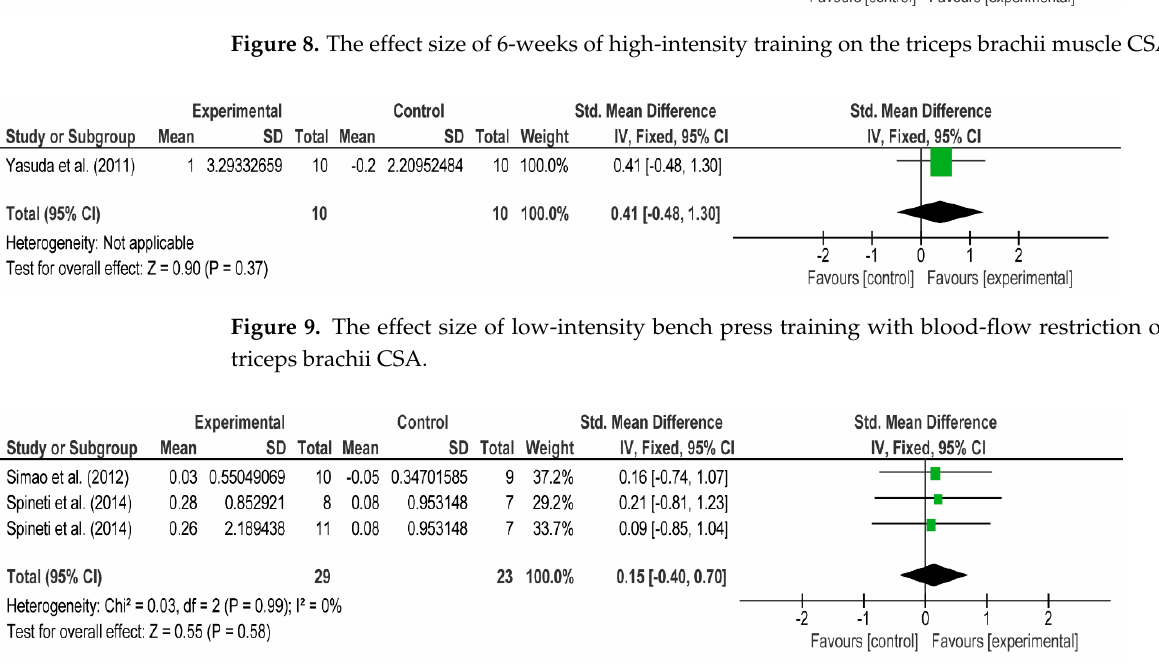
Figure 10. The effect size of 12-weeks of linear periodised resistance training on increasing the triceps brachii MT. The lines for Spineti et al. [90] respectively represent linear periodised large to small muscle training and small to large muscle training groups.